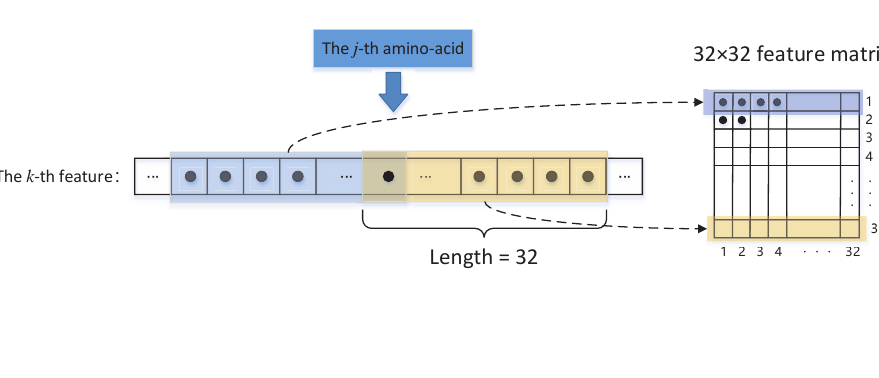
Figure 2. The conversion